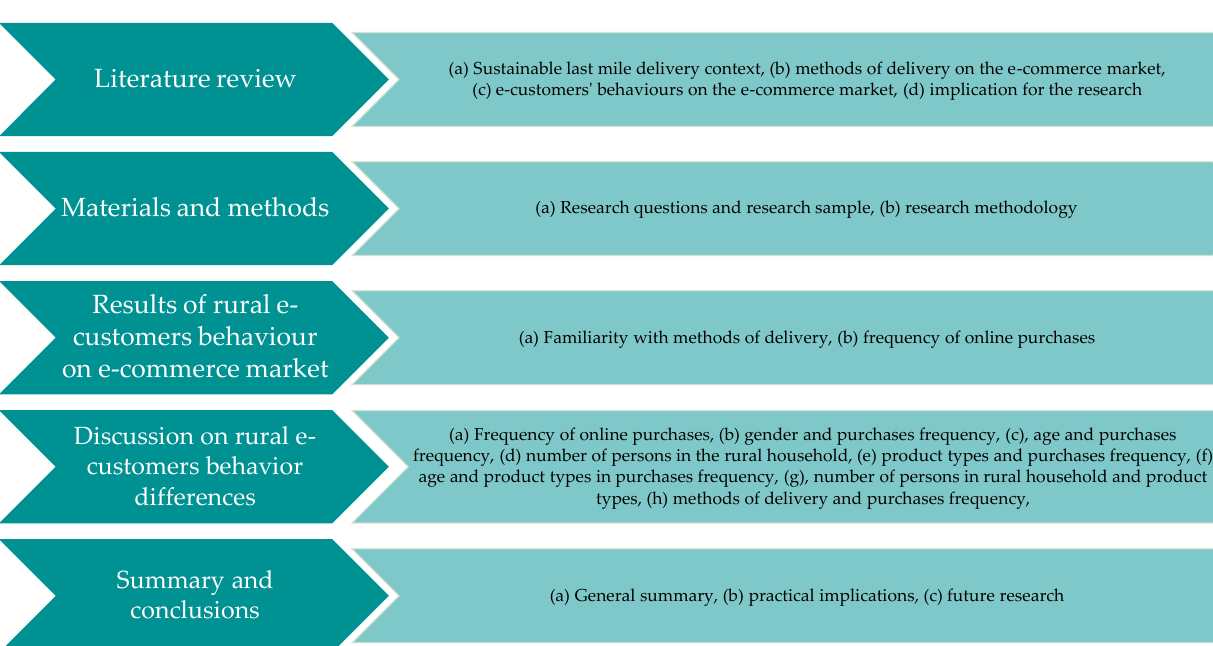
Figure 1. Research methodology (own elaboration).